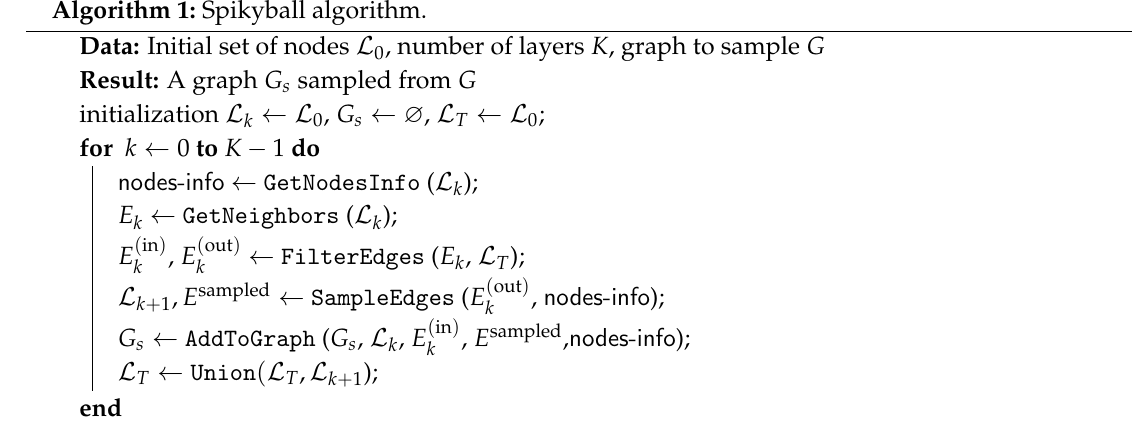
Algorithm 1: Spikyball